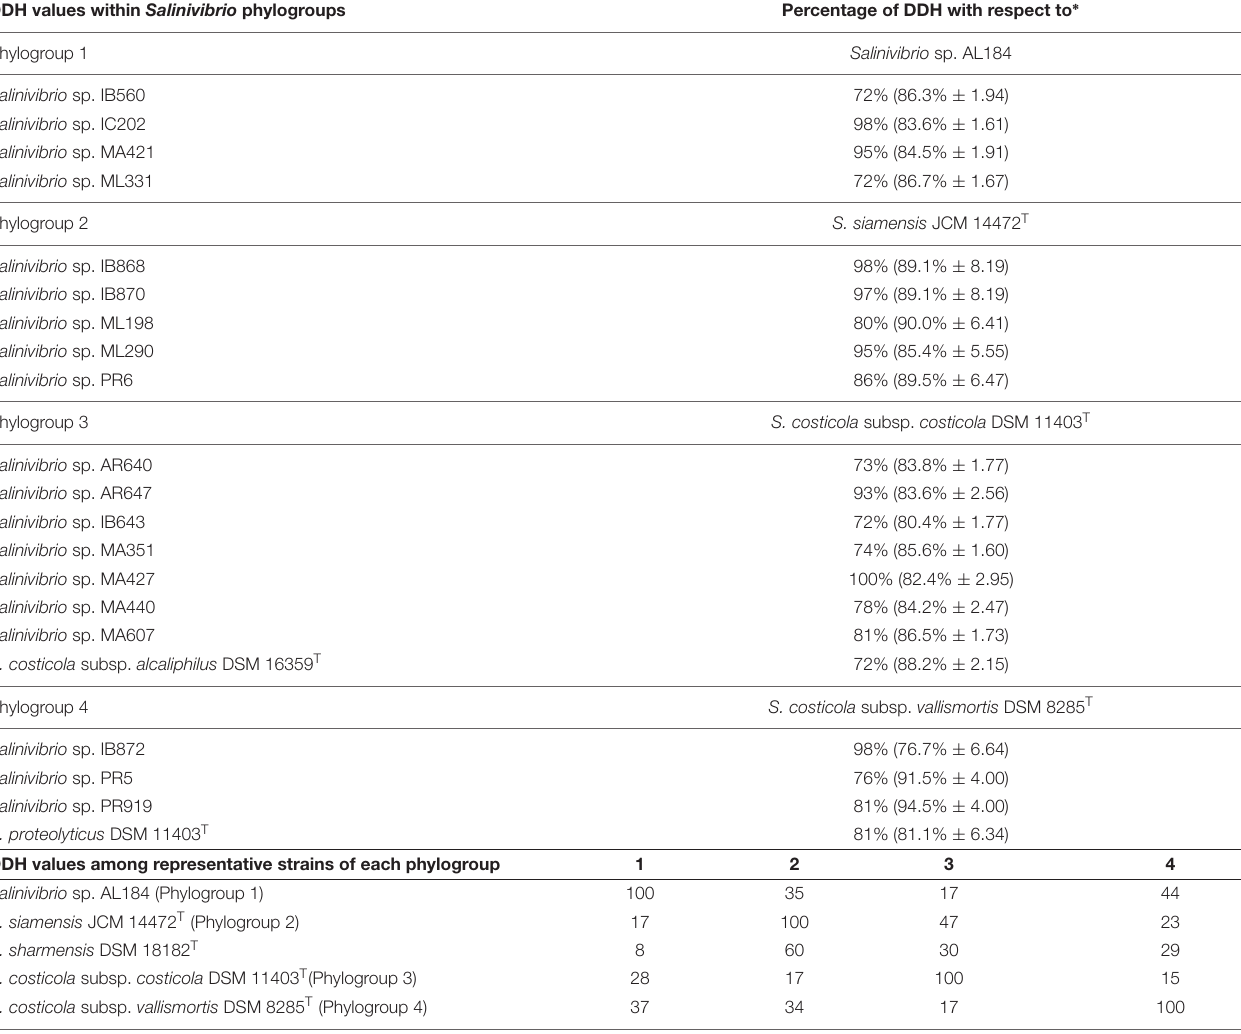
TABLE 3 | DNA–DNA hybridization within Salinivibrio phylogroups and among representative strains of each phylogroup. DDH values within Salinivibrio